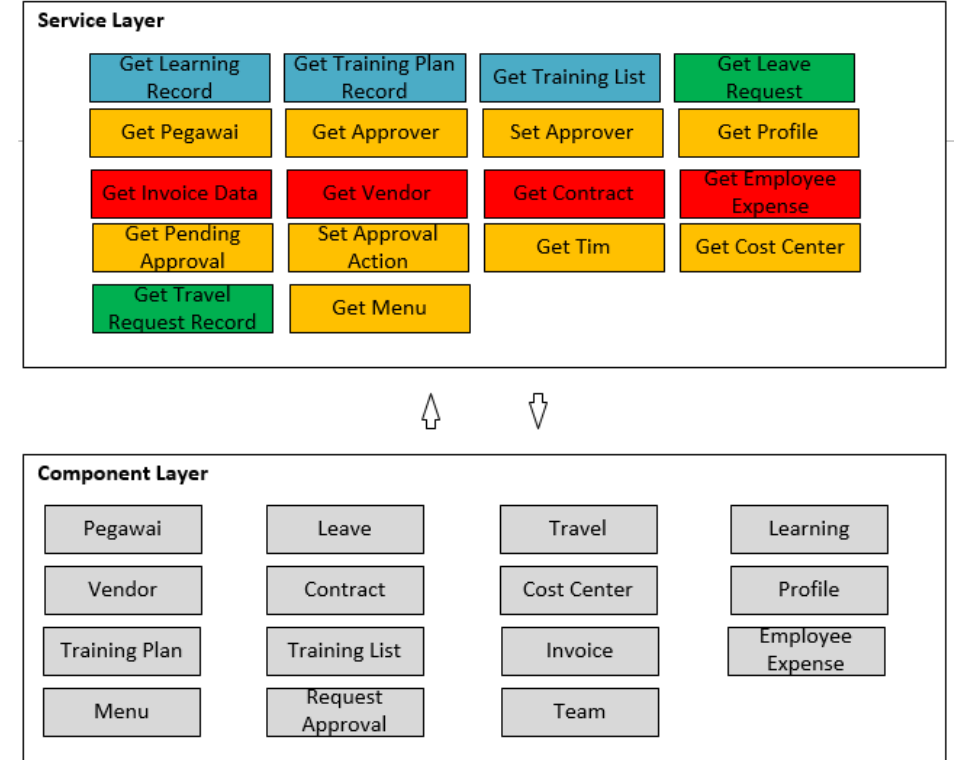
Figure 7. Service and Component